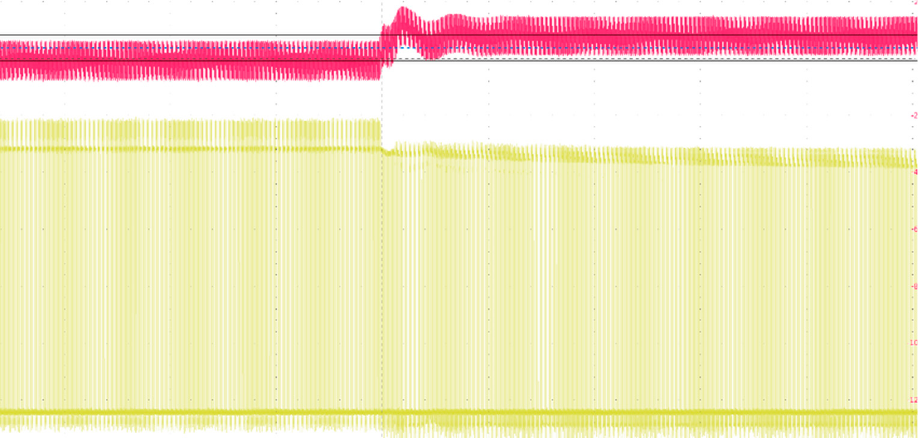
Figure 16. Dynamic current regulation in buck mode operation from 0 A to 8 A. Red line for I OUT (20 A/div) and yellow line for V DS low side (10 V/div).